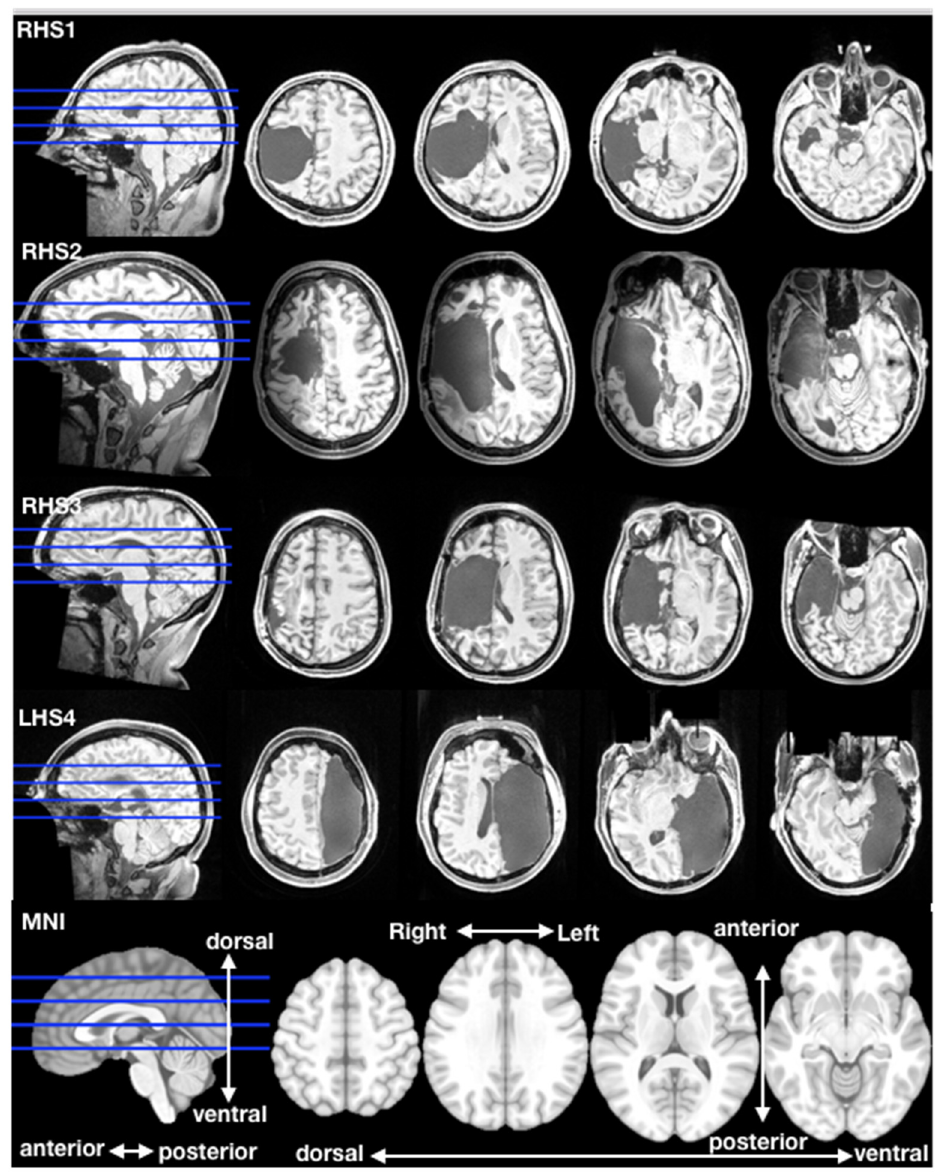
Figure 1. Axial sections of hemispherectomy brain anatomy. Three adult participants with right (RHS1, RHS2, RHS3) and one with left (LHS4) hemispherectomy. Four axial slices were taken in individual native space; axial inter-slice distance was 20 slices (1 mm slice thickness). Orientation legend is shown on the MNI template (bottom row).